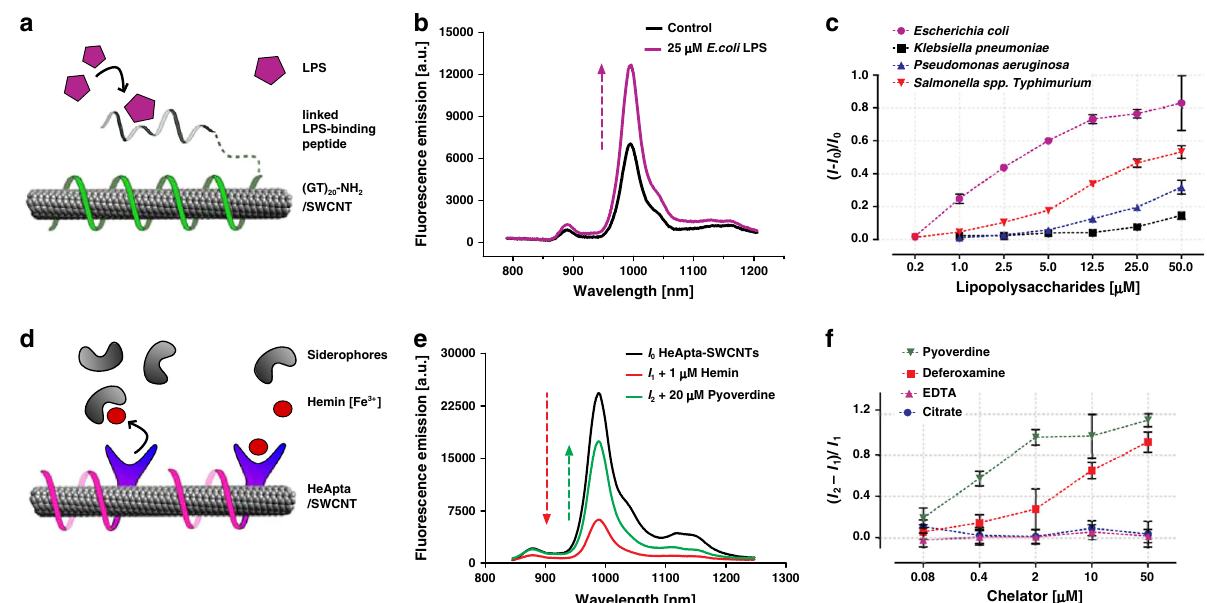
Fig. 2 NIR fl uorescent nanosensors of virulence factors. a Design of an endotoxin sensor for bacterial lipopolysaccharides (LPS). NH 2 -(GT) 20 -ssDNA colloidally stabilizes the SWCNTs and was linked to a LPS-binding peptide via SMCC (succinimidyl 4-(N-maleimidomethyl) cyclohexane-1-carboxylate) chemistry. b NIR fl uorescence increase of bindLPS-(bLPS)-SWCNTs after addition of 25 µ M E. coli LPS. c Dose – response curve of bLPS sensors for LPS from E. coli , K. pneumoniae , P. aeruginosa and Salmonella spp. (n = 3 independent experiments, mean ± SD). d Design of the siderophore sensor. An aptamer (HeApta) binds hemin, which brings Fe 3 + into the proximity of the SWCNT and quenches it. Siderophores can reverse this effect by removing iron (Fe 3 + ), which increases fl uorescence again. e Exemplary spectra of HeApta-SWCNTs. Addition of hemin ( I 0 to I 1 ) quenches their fl uorescence and addition of siderophores (pyoverdine) increases it again ( I 1 to I 2 ). f Calibration of chelating agents with different stability constants ( K f ) for iron (Fe 3 + ), added to HeApta-SWCNTs with 1 µ M hemin concentration. Pyoverdine ( K f = 10 32 ), deferoxamine ( K f = 10 30 ), EDTA ( K f = 10 25 ), hemin ( K f = 10 22 ), citrate ( K f = 10 12 ) 78,89 – 91 ( n = 3 independent experiments, mean ±